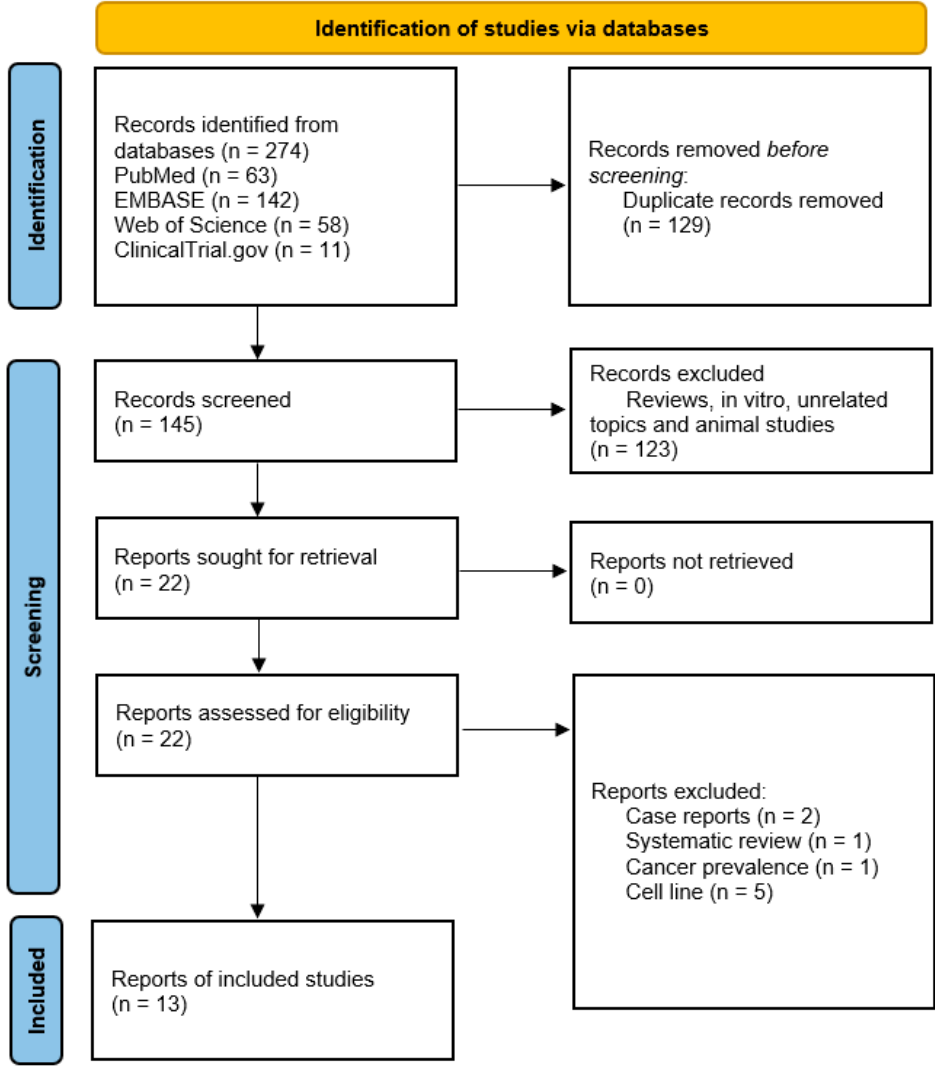
Figure 2. PRISMA chart of the reported studies [119]. We included randomized control and single- arm studies demonstrating thalidomide e ffi cacy in GBM treatment. During screening, we excluded review articles, in vitro studies, unrelated topics, and animal studies. review articles, in vitro studies, unrelated topics, and animal